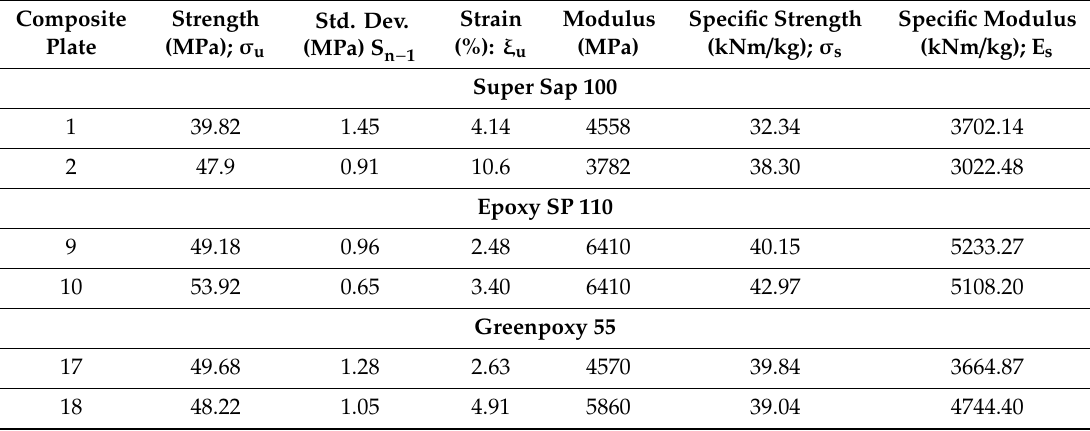
Figure 3. Scanning electron microscopy images of the tensile specimen fractures: ( a ) #1, ( b ) #2, ( c ) #9, ( d ) #10, ( e ) #17, ( f ) #18. Table 2. Tensile properties of hemp fibre